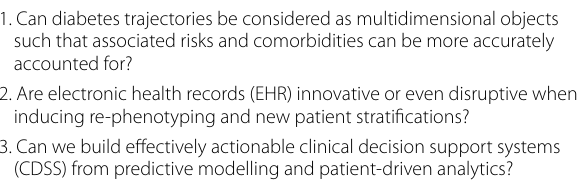
Table 1 Key concepts in diabetes from a systems medicine